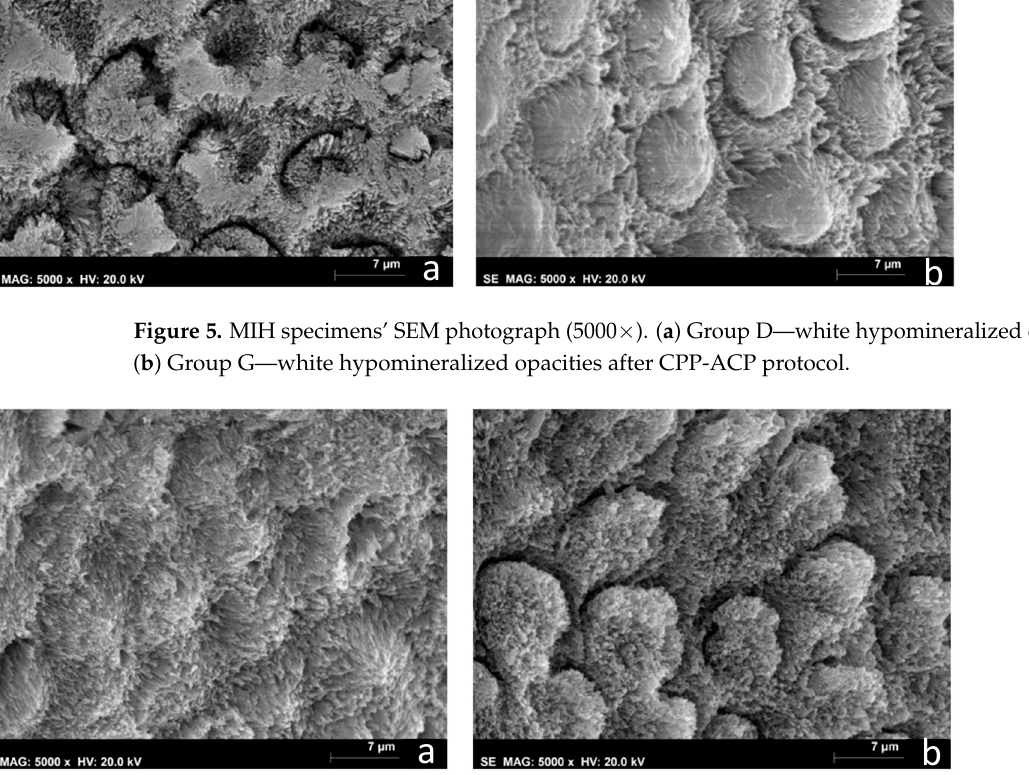
Figure 6. MIHs specimens’ SEM photographs (5000×). ( a ) Group E—yellow hypomineralized opacities; ( b ) Group H—yellow hypomineralized opacities after CPP-ACP protocol.